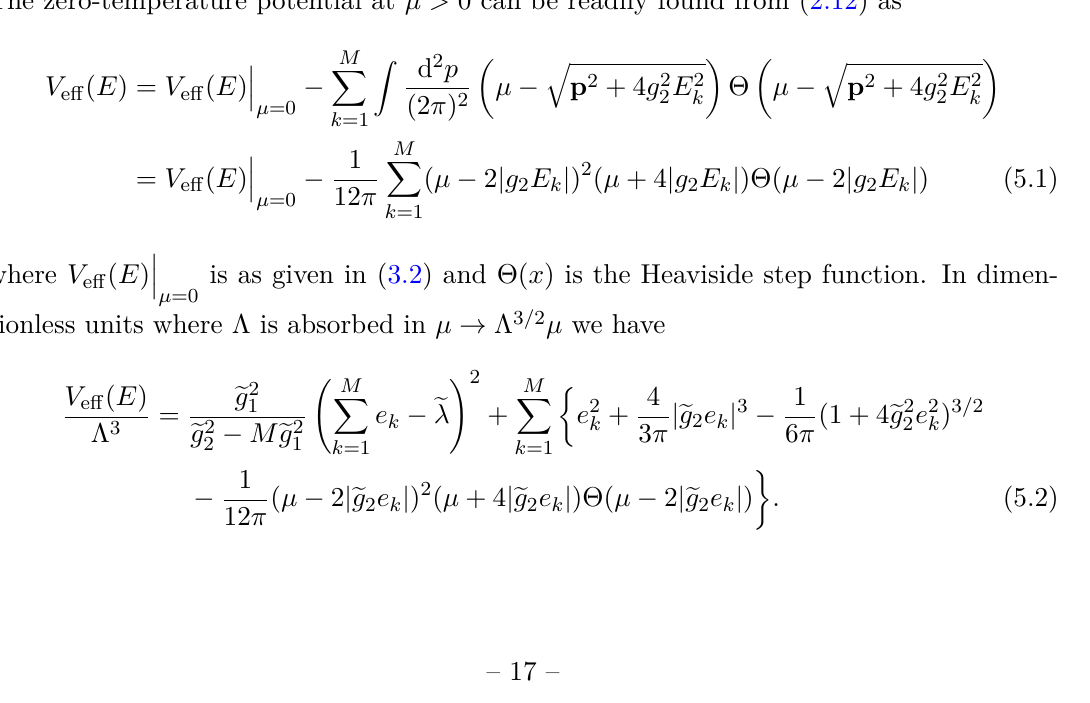
Figure 11 . (a) The phase diagram for M = 3 at µ = 0 with limit. The plotted observable is Min ( | e 1 − e 2 | , | e 2 − e 3 | , | e 3 − e 1 | ) . Within the red triangle the three e k differ from one another, indicating spontaneous symmetry breaking U (3) → U (1) 3 . (b) The e T -dependence of { e k } at e λ = 0 . 05 . There is a range of T in which the three e k are all